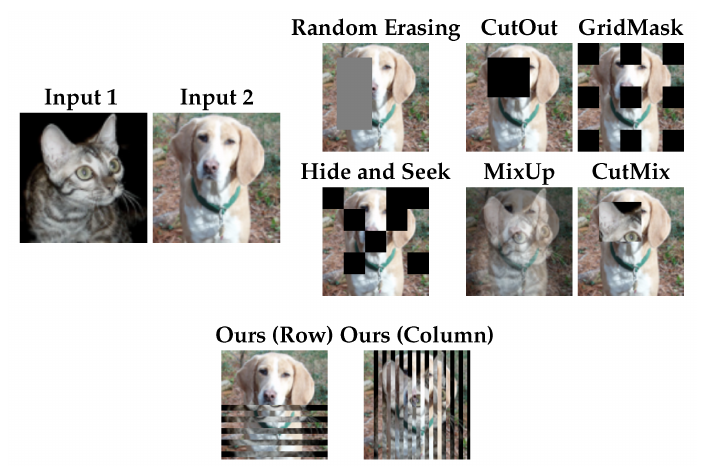
Figure 1. Comparison of different data augmentations against the proposed